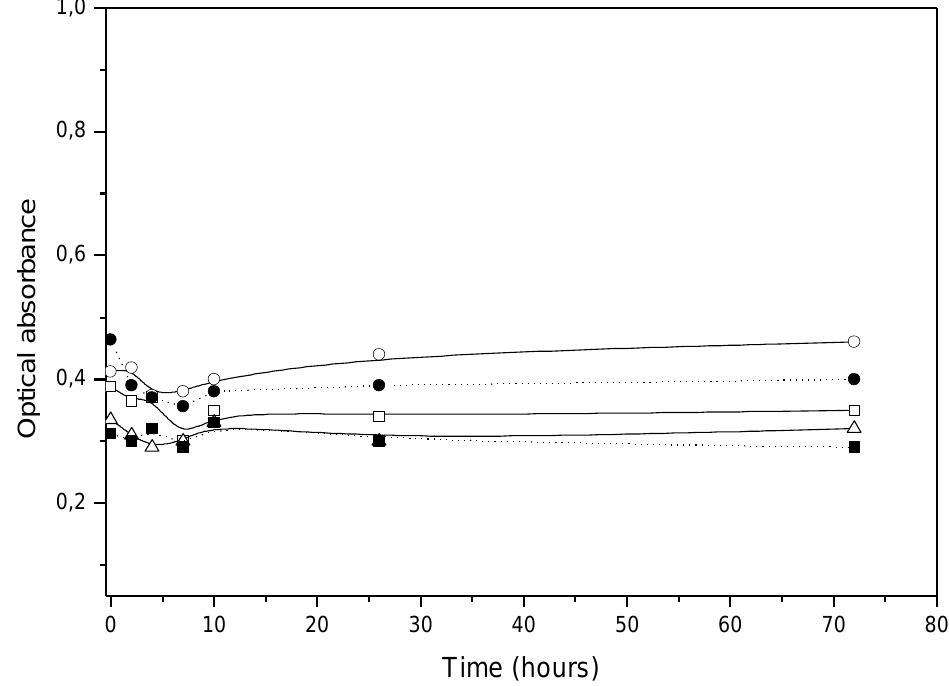
Figure 6. Aggregation kinetics of the (□) EPI; (○) CS; (∆) PhS; (■) PhS-1 mg/m 2 IgG; and (●) PhS-2.5 mg/m 2 IgG nanocapsules when immersed in DMEM medium supplemented with fetal bovine serum